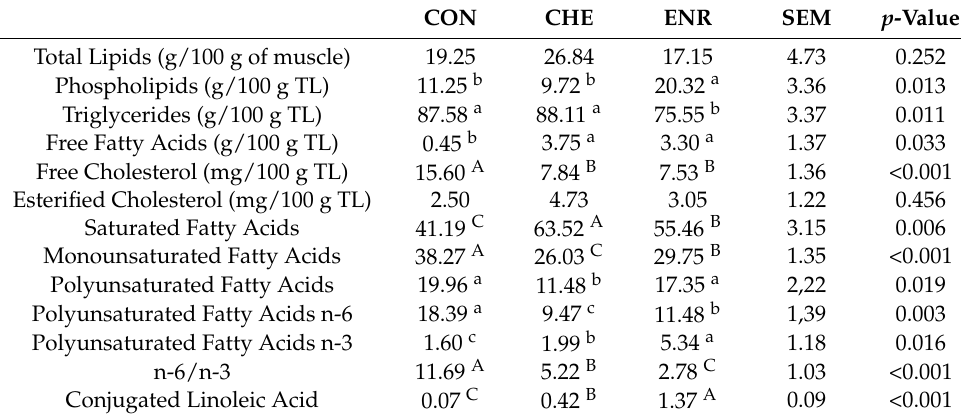
Table 5. Effect of the diet on the lipid profile of skeletal